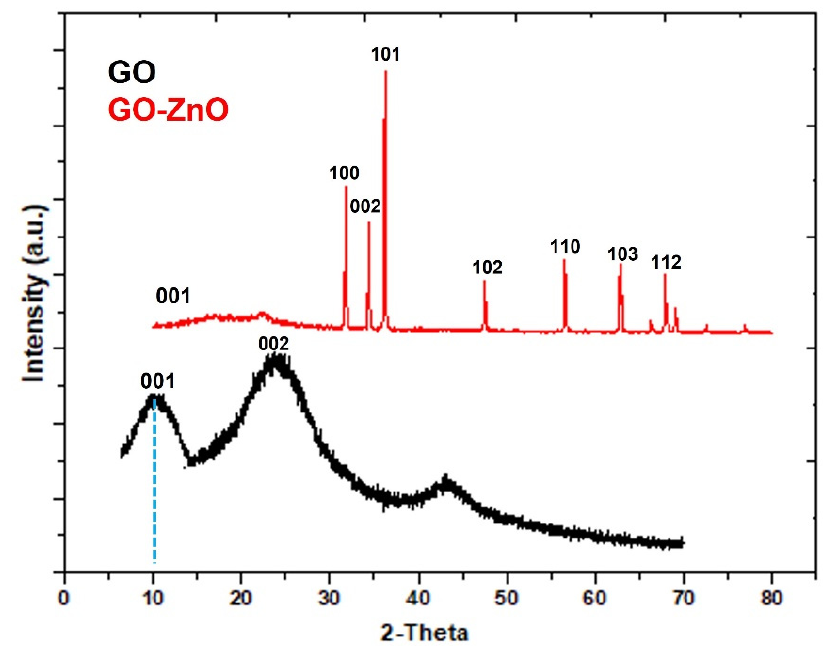
Figure 2. XRD spectra of (i) GO and, (ii) GO-ZnO composite.